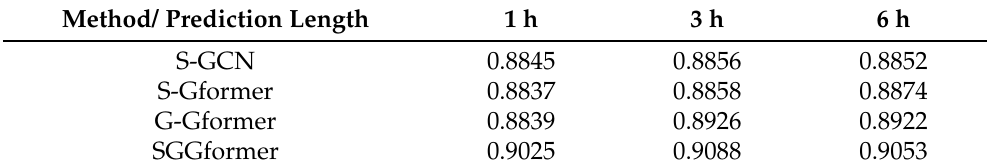
Figure 14. Comparison of results of ablation experiments. Table 4. The ablation analysis on accuracy performance.